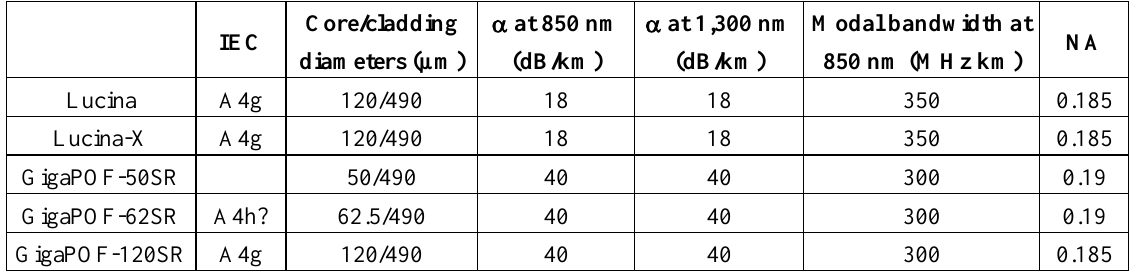
Table 1. Overview of the commercially available